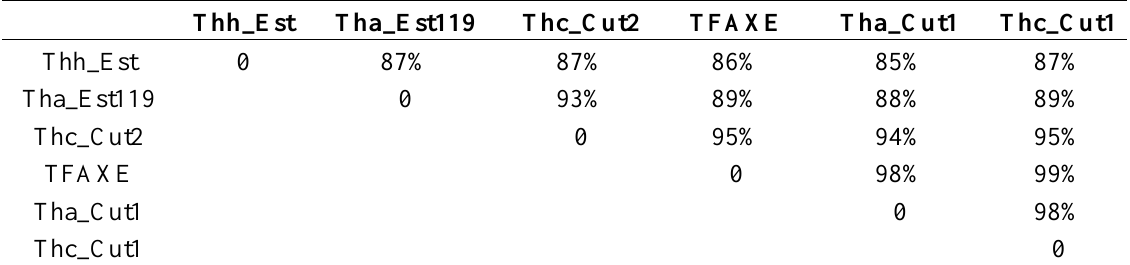
Figure 1. Phylogenetic tree based on amino sequences of the Thh_Est and other highly homologous hydrolases from Thermobifida . The calculation is based on a sequence distance method and utilizes the Neighbor Joining (NJ) algorithm of Saitou and Nei